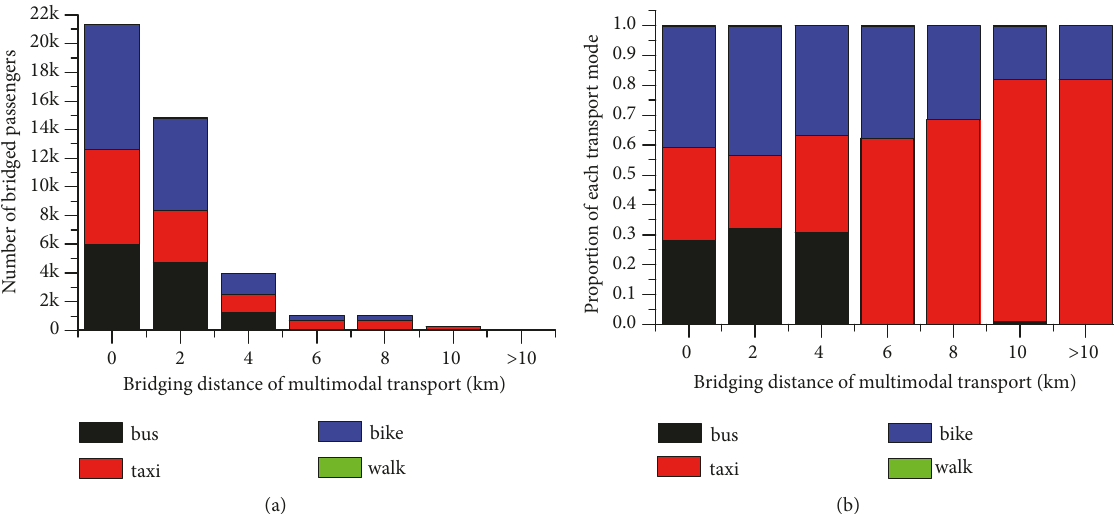
Figure11:Alternativesoftransportmodes.(a)showsthenumbersofbridgingpassengersaredecreasingsharplywiththeincreasesinbridging distance; (b) shows the proportion of passengers choosing the different transport mode with the changes of bridging distance.